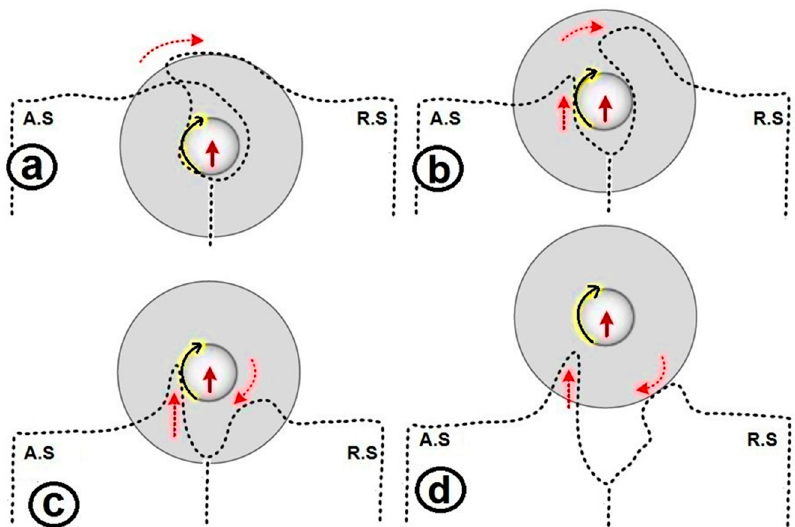
Figure 14. Schematic of the progression of material disruption in the exit zone (Top view of the tool-workpiece interaction); ( a ) tool approaches to the extremity edge of the workpiece; shortage of forward material, ( b ) the leading edge of the pin arrives to the free surface; disruption happens, ( c ) the pin leaves the plate; a hole is left behind, and ( d ) the pin and shoulder exit from the workpiece; a keyhole-shaped hole appears as the exit defect.